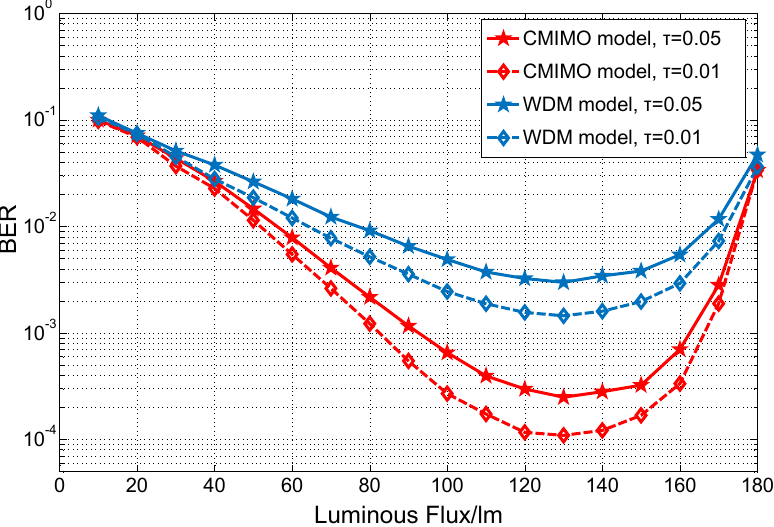
Figure 7. Error performance for the CMIMO model and the conventional WDM model under different interference coefficient under CCT = 5700